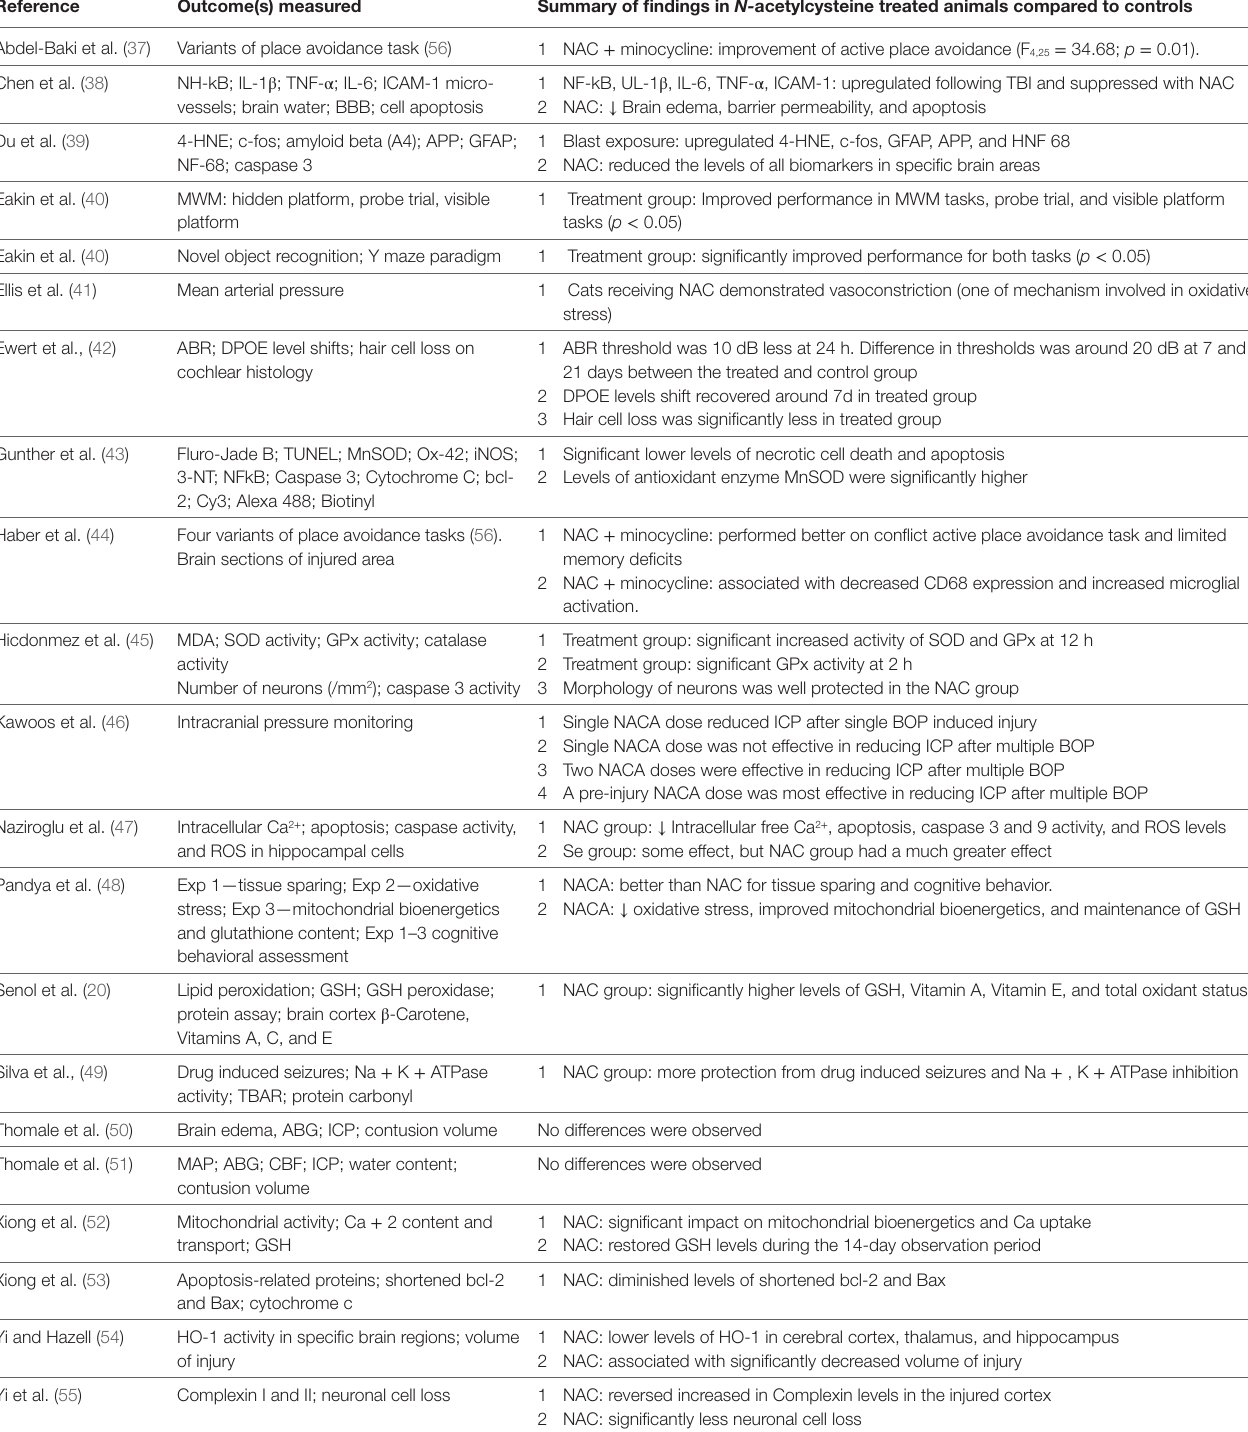
taBle 3 | Outcome measures and summary of findings in 20 animal studies (21 experiments).